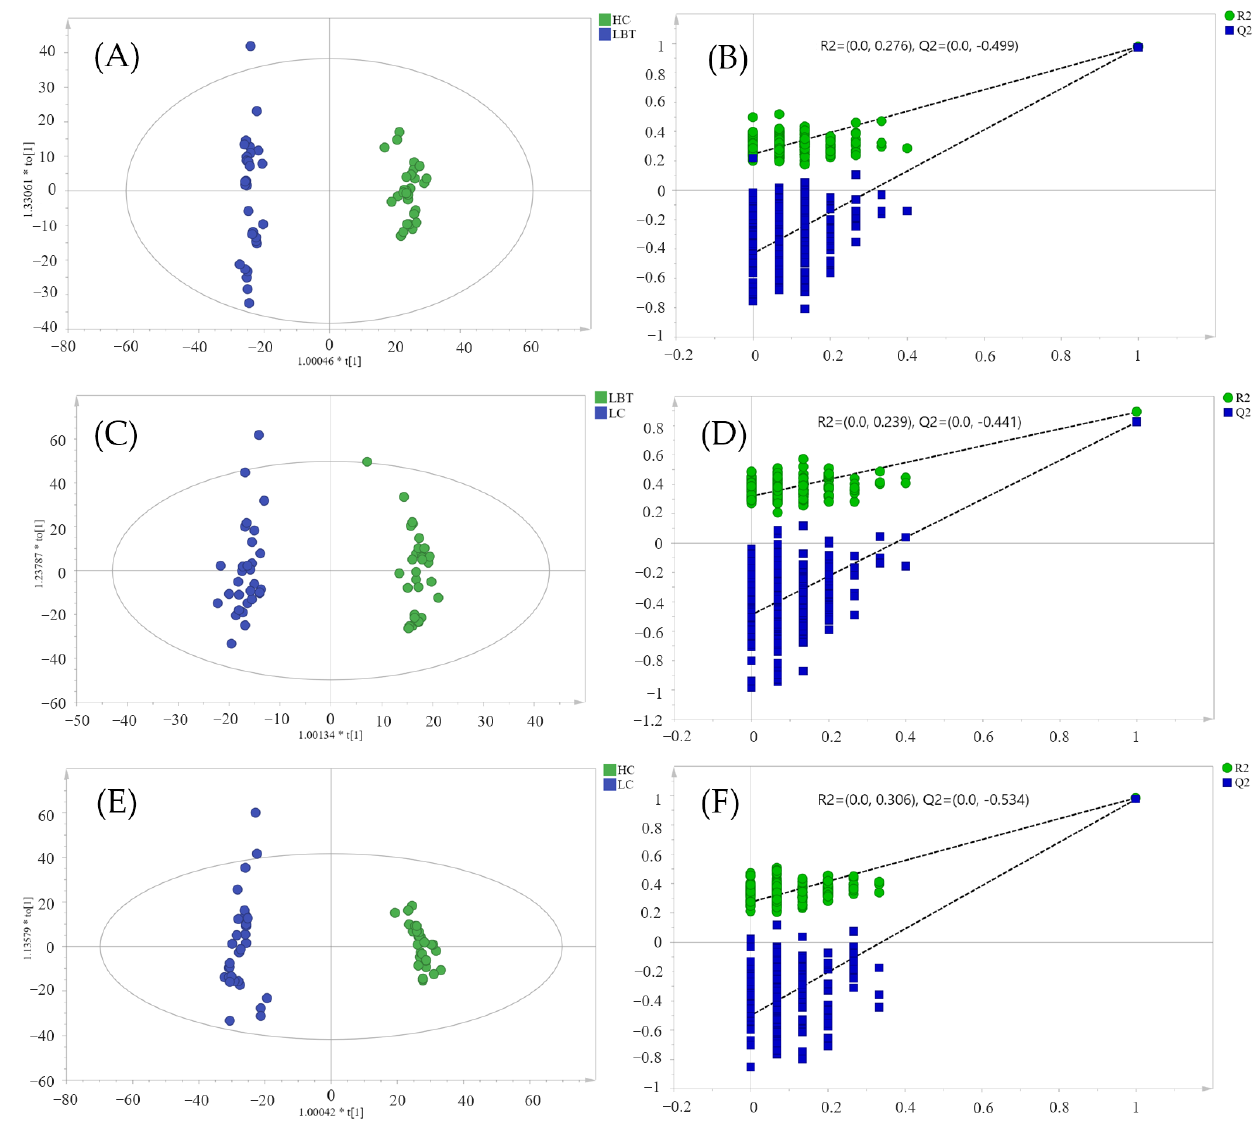
Figure 2. Orthogonal partial least-squares-discrimination analysis (OPLS-DA) and permutation test results of LC, LBT, and HC (LC, laryngeal cancer patients; LBT, laryngeal benign tumor patients; HC, healthy crowds). OPLS-DA model of HC and LBT ( A ), LBT and LC ( C ), HC and LC ( E ).